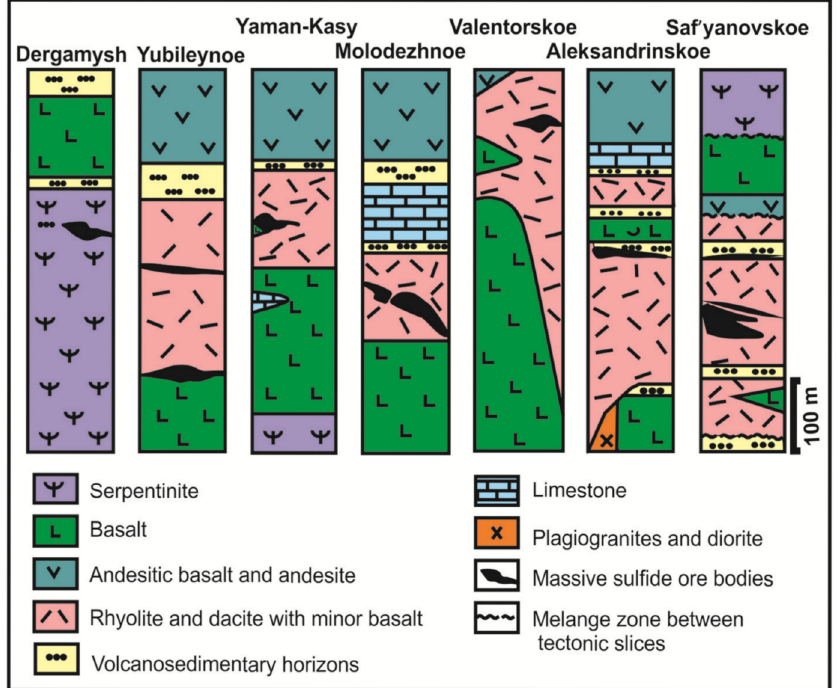
Figure 3. Schematic geological cross-sections of the Urals VHMS deposits studied (modified after [19,45,51]). Deposits of Baymak type formed in the upper sequences of oceanic rifted arcs [39]. These deposits (Valentorskoe, Aleksandrinskoe) are similar to subtype U3 and occur in the upper ore-bearing levels of the bimodal sequences within the andesitic dacite upper units. Relatively to the Uralian type, the Baymak-type deposits show lower S (<30 wt.%) and Te (<30 ppm) with higher Cu + Zn and